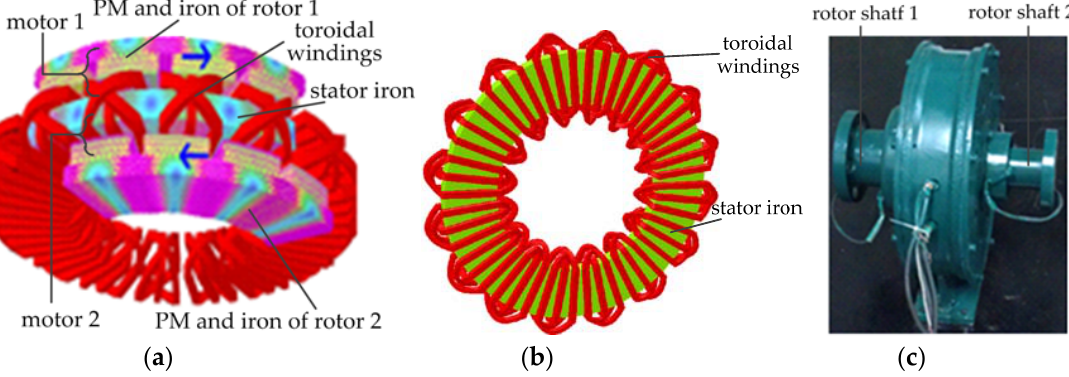
Figure 1. Model of the motor. ( a ) 3D model; ( b ) overview of the stator; and ( c ) the prototype of the motor.